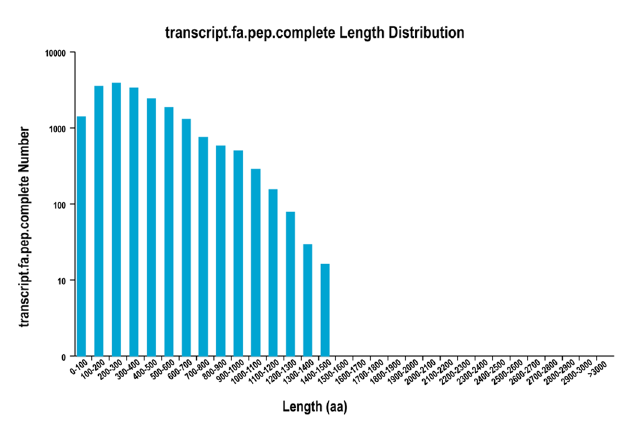
Figure 3. The distribution of the coding sequence lengths of the complete open reading frames. The x-axis represents the coding sequence length and the y-axis represents the number of predicted open reading frames.